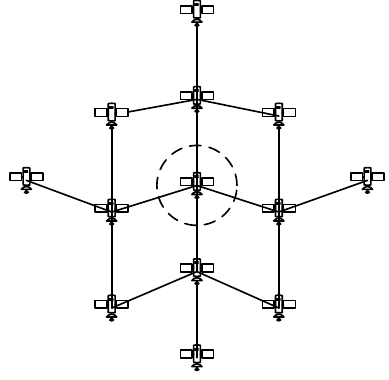
Figure 2. Inter-satellite links within two Figure 2. Inter ‐ satellite links within two hops.